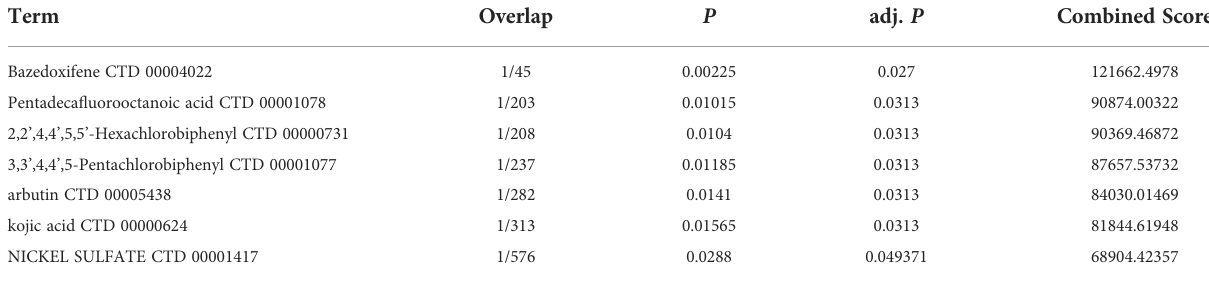
TABLE 4 Predict potential drug.